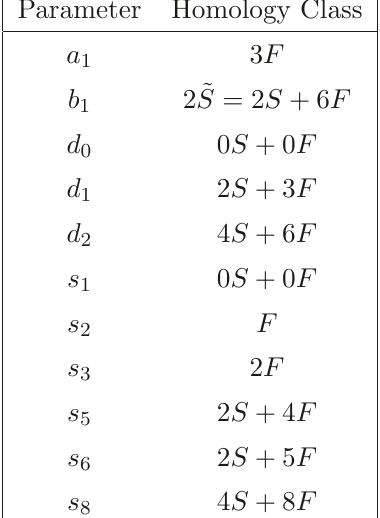
Because s 1 and d 0 are constants, the d 3 any new nonabelian gauge groups. Meanwhile, the v 4 factors corresponds to the expect SU(3) NHC on F 3 . But the b 4 has therefore been unHiggsed to an SU(4) tuned on b 1 = 0. Since [ b 1 ] = 2 ˜ S , b 1 = 0 is a genus-two curve, and the spectrum includes two hypermultiplets in the adjoint ( 15 ) representation. Additionally, the codimension-two locus ˜ s 6 = b 1 = 0 contributes ten 10 hypermultiplets, while the locus ( ˜ d 2 ˜ s 2 hypermultiplets. This charged spectrum agrees exactly with anomaly